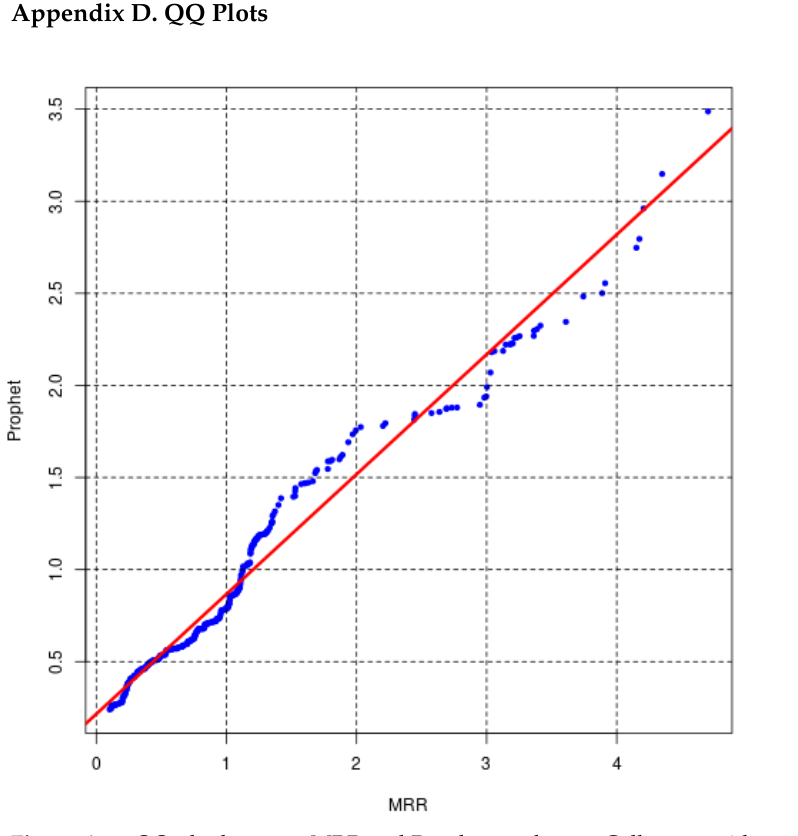
Figure A10. QQ plot between MRR and Prophet on dataset Callcenter with quality measure MASE overall